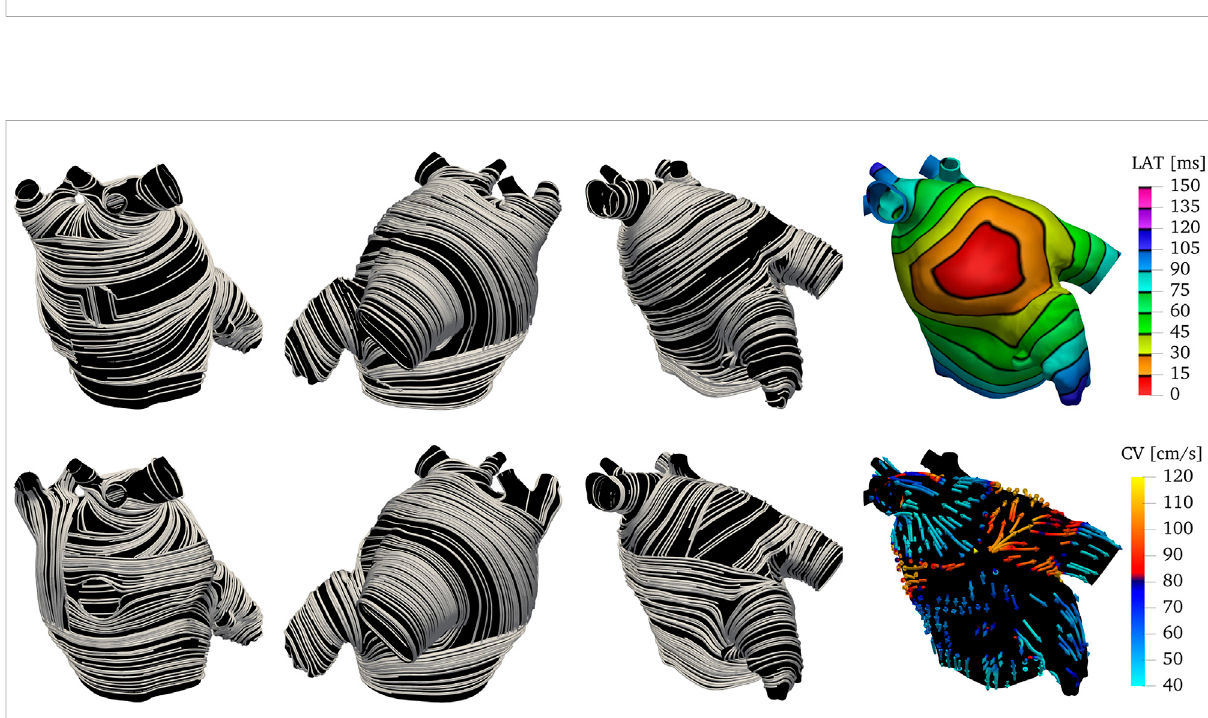
FIGURE 6 Endocardial (top) and epicardial (bottom) fi ber fi elds, activation times and conduction velocities on M52. The presence of the left common pulmonary trunk is easily accounted by the algorithm. The Bachmann ’ s bundle on the epicardial layer wraps around the left atrial appendage. Note that the orientation of the fi bers in the right carina and in the left lateral ridge are an improvement over existing methods in representing the anatomical muscle bundles. Similarly to Fastl et al. (2018) the fi bers in the right posterior pulmonary veins are set longitudinally instead of circumferentially. The activation times and the conduction velocities show two main path of activations: one circumferential through the Bachmann ’ s bundle and another superior and then posterior through the septoatrial